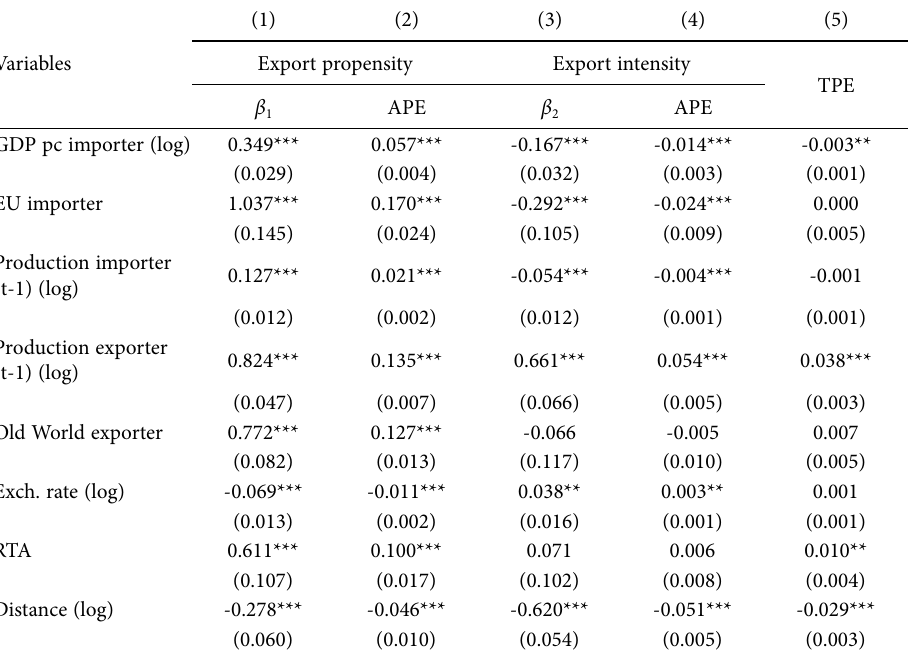
Table 1. 2P-FRM estimations, Average Partial Effects and Total Partial Effect.